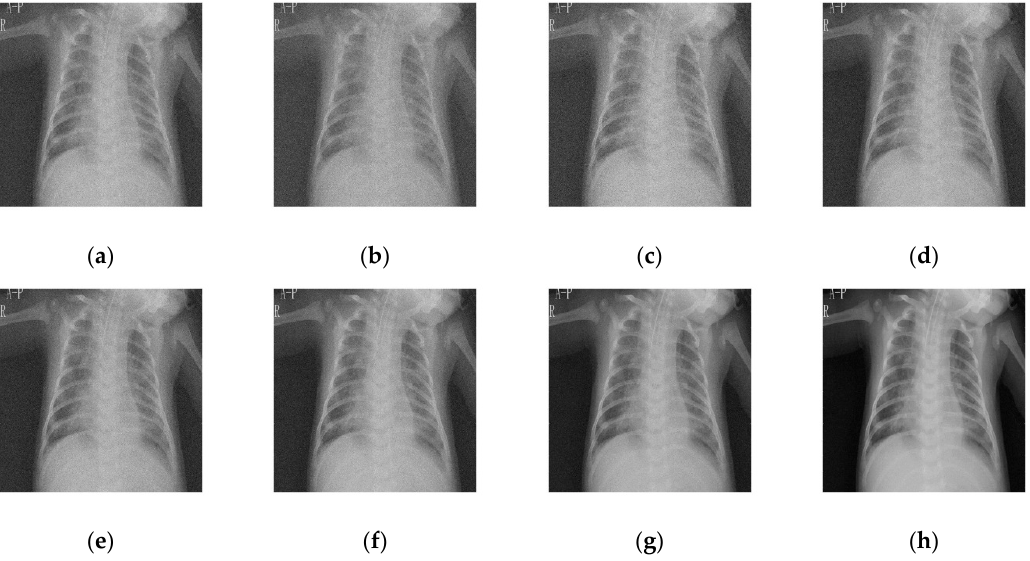
Figure 6. Denoised COVID-19 CT image 3 from the ( a ) [10], ( b ) [11], ( c ) [12], ( d ) [13], ( e ) [14], ( f ) [11], ( g ) [16], and ( h ) proposed frameworks, respectively.